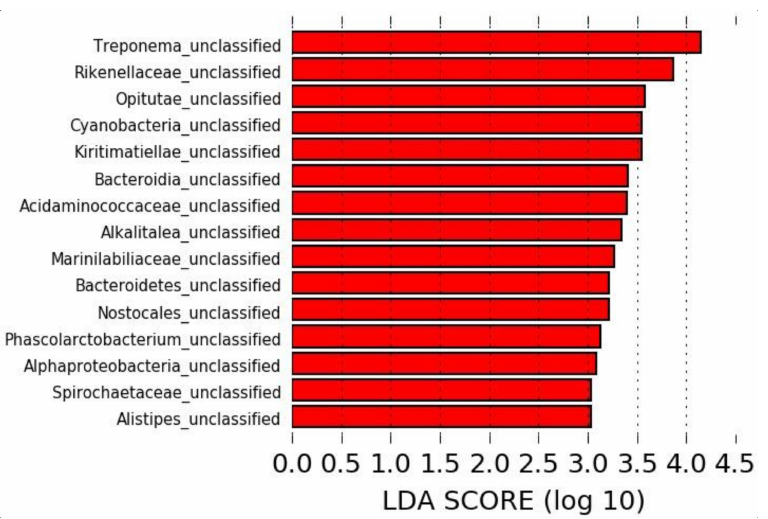
Figure 2. Linear discriminant analysis effect size (LEfSe) identifying taxa overrepresented in the microbiota of horses pre-antibiotic administration.